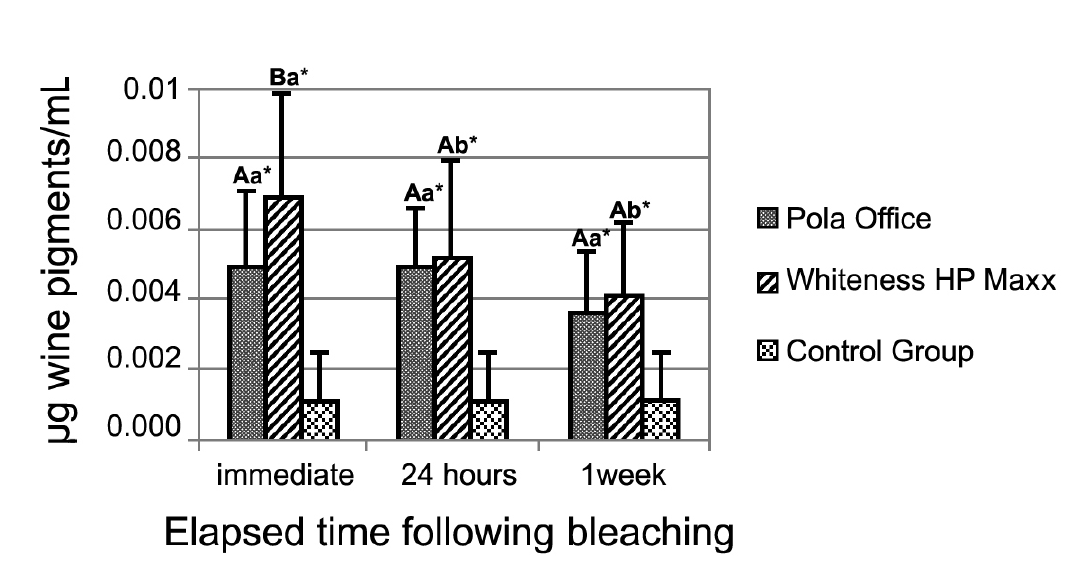
FIGURE 1- Bar graph of mean values (± SD) of wine pigment uptake (mg wine pigments/mL) from bleached and unbleached (control) enamel